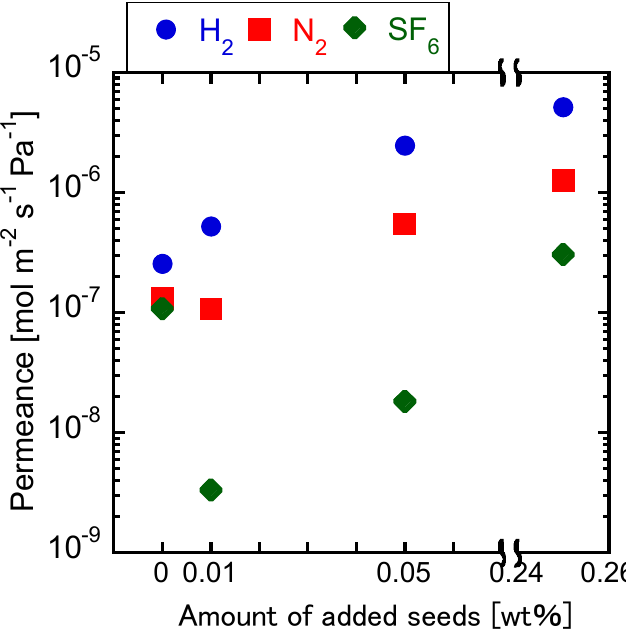
Figure 6. Single gas permeances through the membranes crystallized with varying seed crystal concentrations. (1 SiO 2 :0.8 TMAdaOH:0.8 HF:4.6 H 2 O, x wt% CHA seeds, 16 h at 423 K).